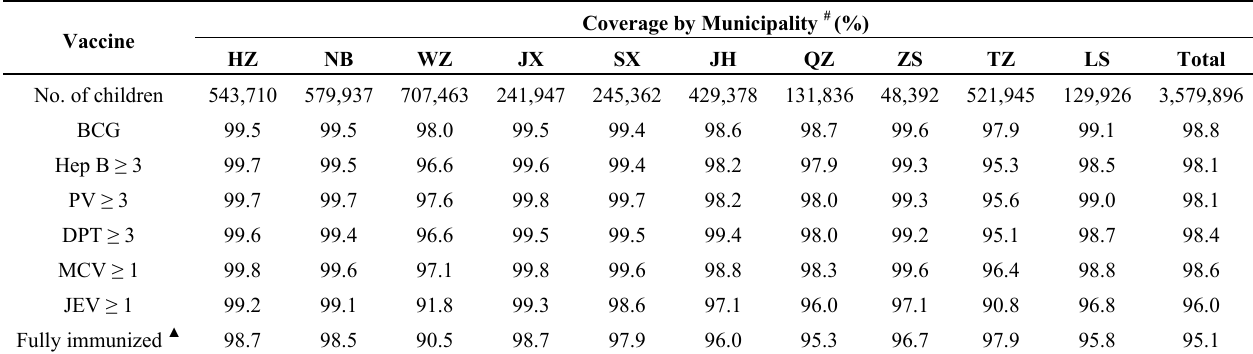
Fully immunized ▲